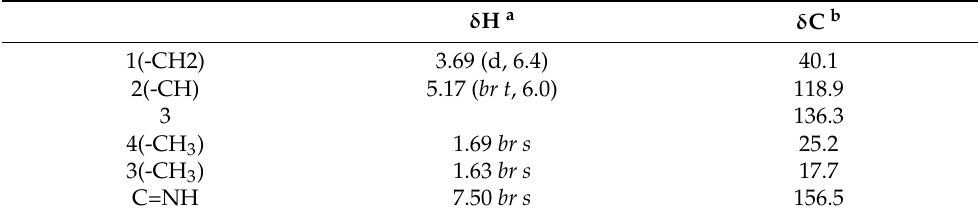
Table 1. 1 H and 13 C NMR spectral data of galegine.